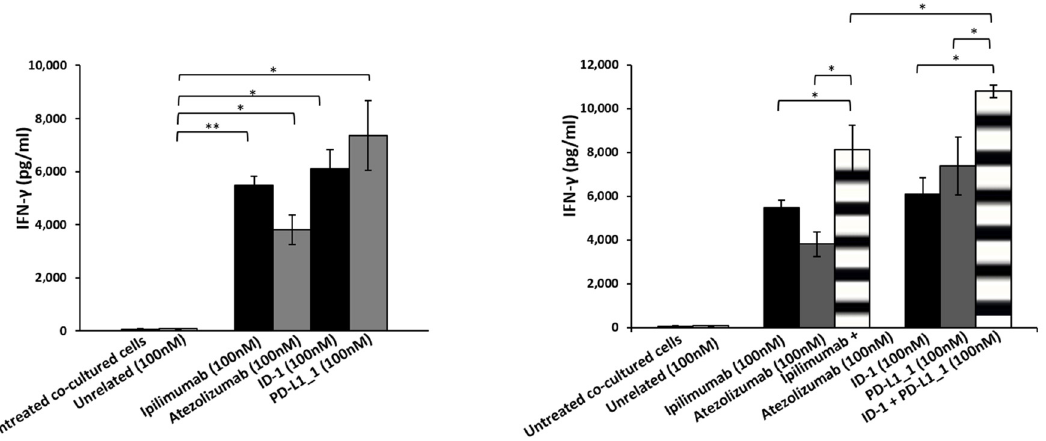
Figure 4. Effects of novel immunomodulatory mAbs on the secretion of IFN- γ in co-cultures of MDA-MB-231 tumor cells with hPBMCs. Levels of IFN- γ secreted by hPBMCs co-cultured with tumor cells and treated with anti-CTLA-4 (black bars) or anti-PD-L1 (dark grey bars) mAbs and their combination (striped bars) at the indicated concentration for 48 h. Cells untreated or treated with an unrelated IgG were used as negative (white and grey bars, respectively). Error bars depict means ± SD. p -values for the indicated compounds are: ** p < 0.01; * p < 0.05.